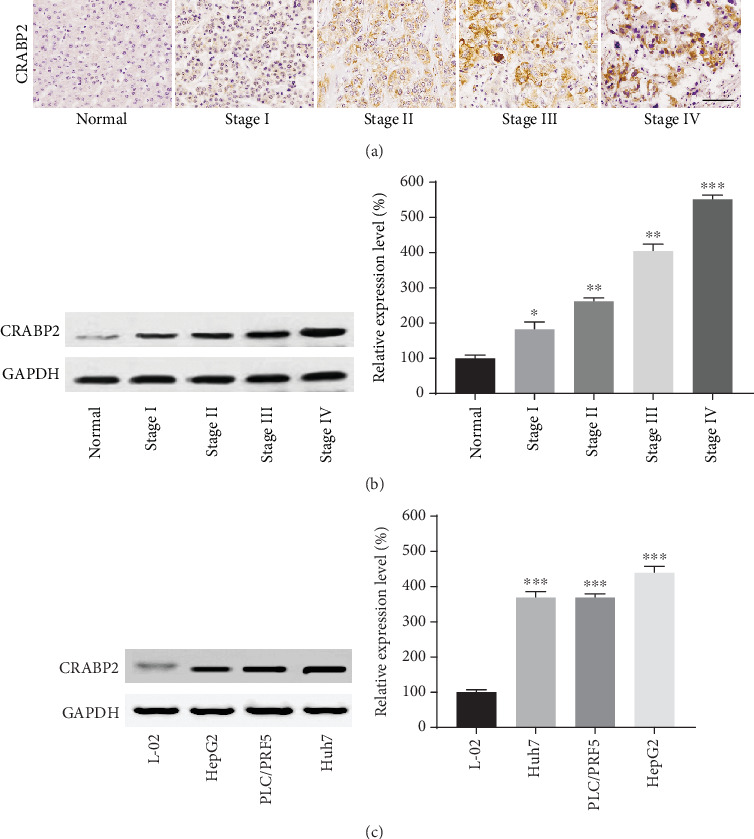
The expression change of CRABP2 in HCC tissues and cell lines. (a) Immunohistochemistry was performed to determine the expression of CRABP2 in HCC of different grades. (b) Western blotting was applied to determine the protein expression of CRABP2 in HCC of different grades (I-IV). n = 5. (c) CRABP2 expression levels in L-02, HepG2, PLC/PRF5, and Huh7 cells were detected by western blotting. GAPDH was used as an internal control. n = 7. One-way ANOVA was used in multigroup comparison. Scale bar = 50 μm. All data are presented as mean ± SEM. ∗P < 0.05, ∗∗P < 0.01, ∗∗∗P < 0.001 vs. normal or L-02.